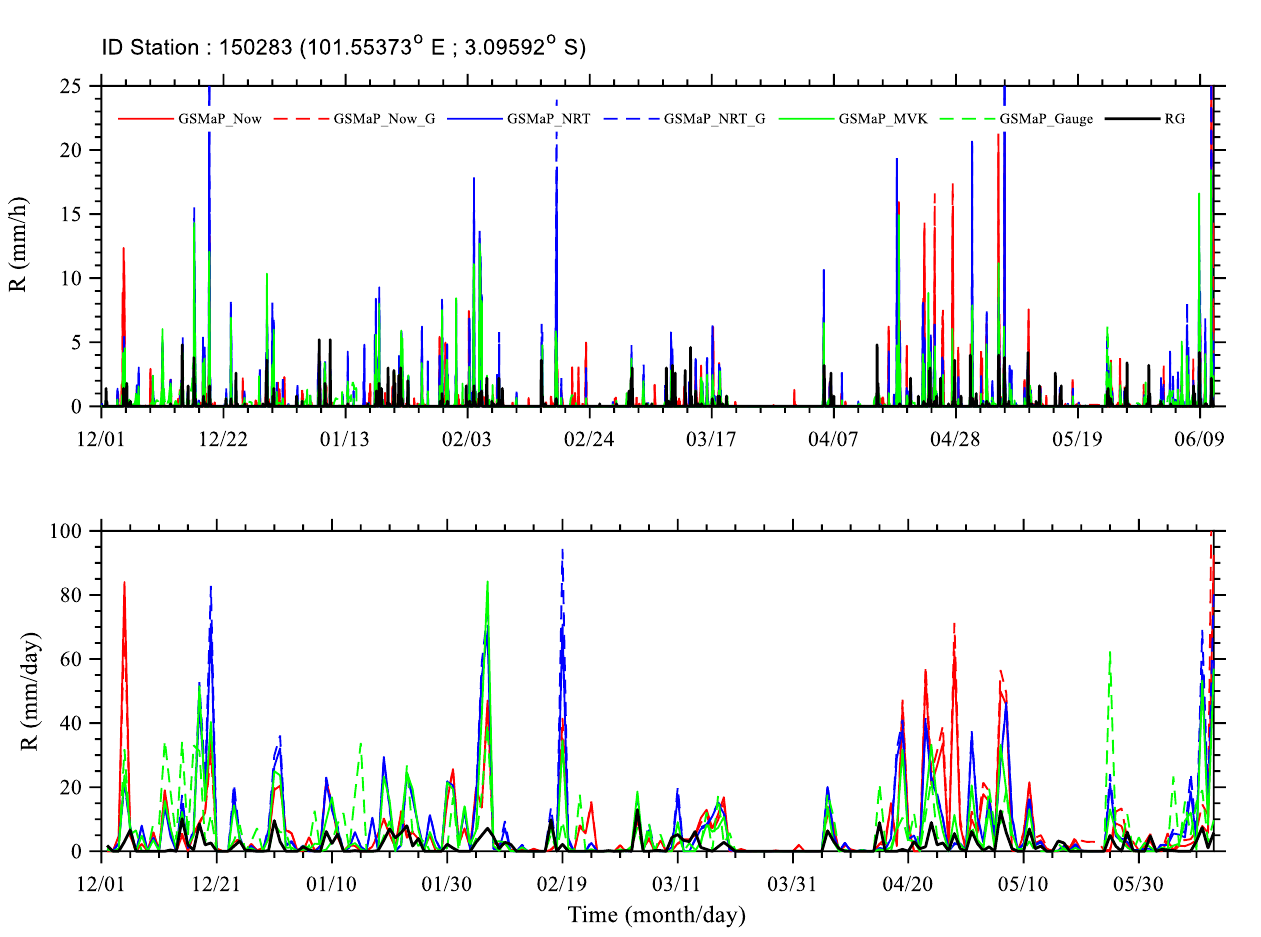
Figure 3. Time series of hourly ( top ) and daily ( below ) data of GSMaP and RG data for ID station of 150283. The location of station is given in the plot title. Table 5. The mean of validation data matrix for hourly data for all stations.